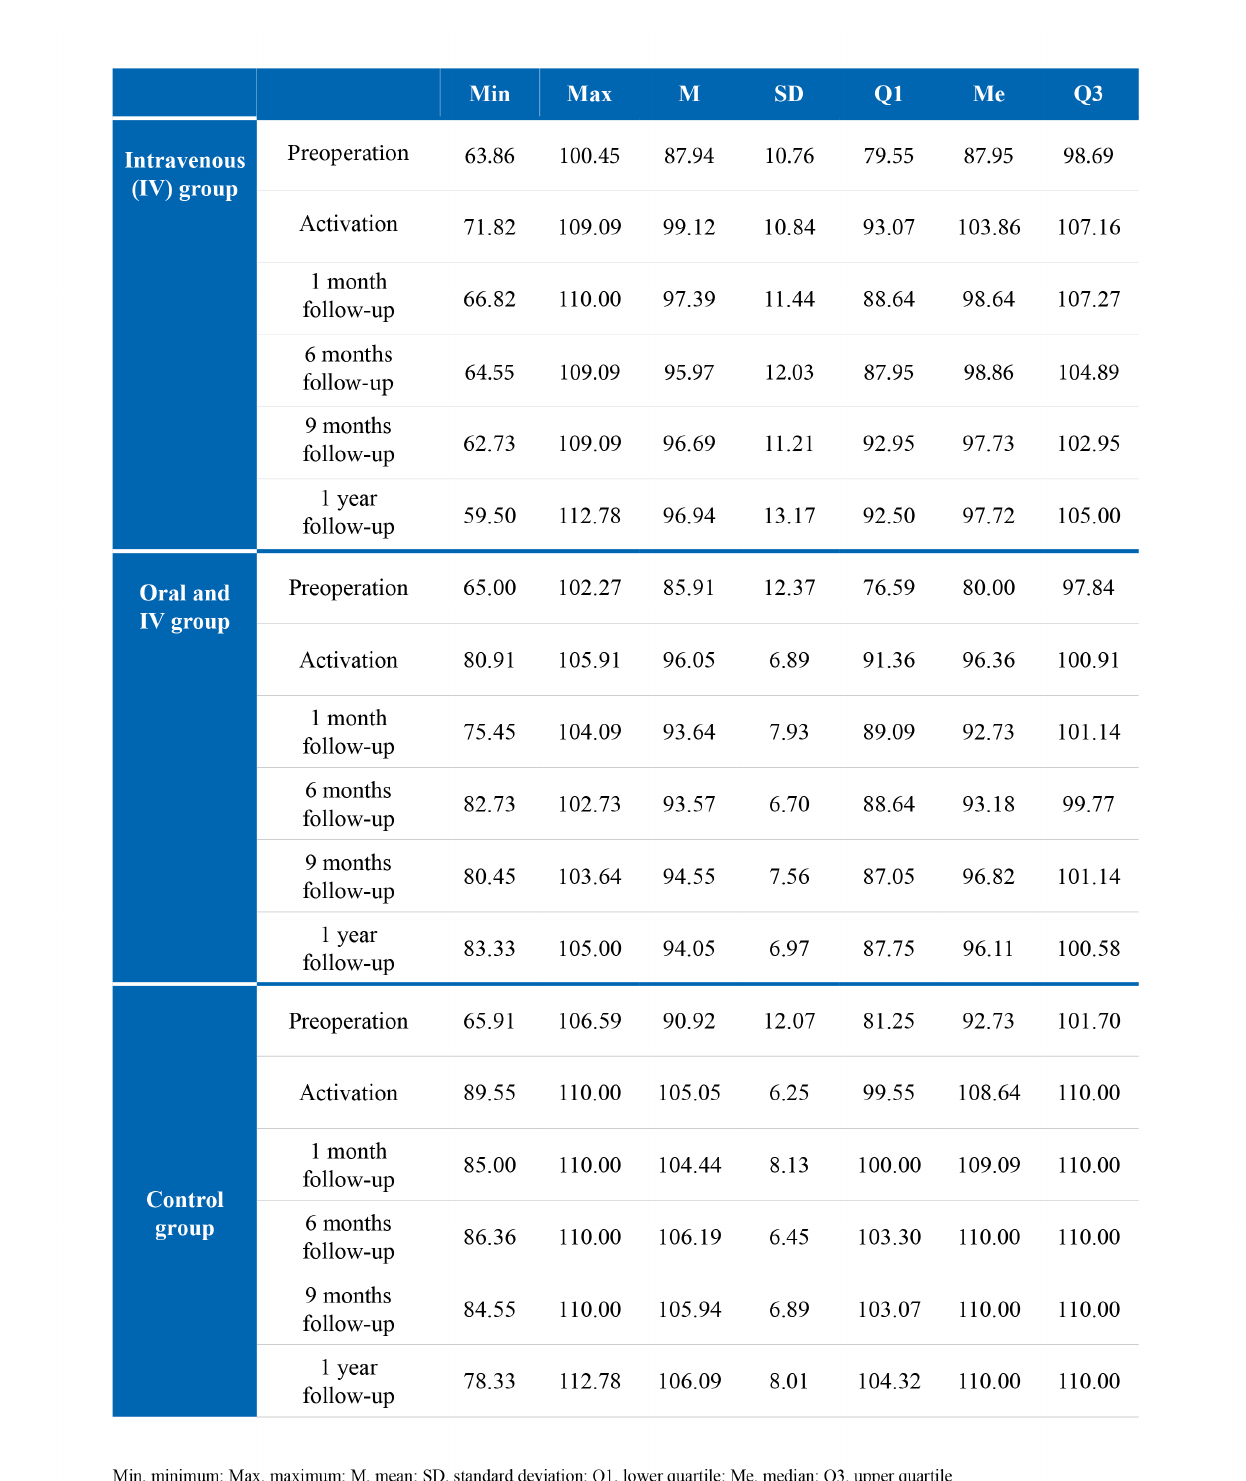
TABLE III - Hearing thresholds of patients from the three groups at each time